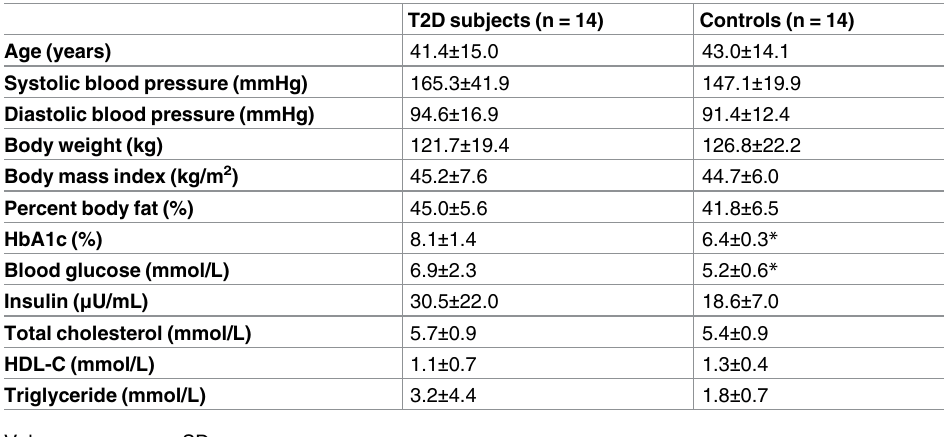
Table 1. Clinical characteristics of female study